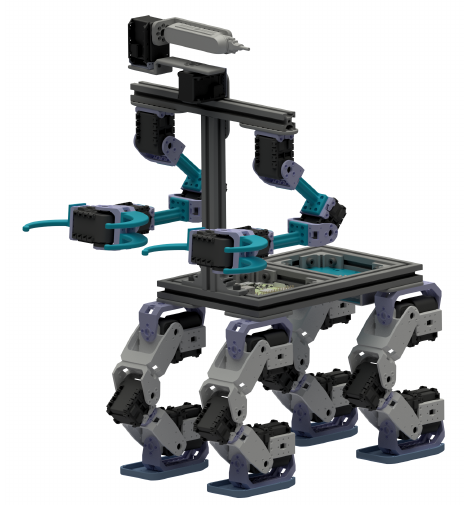
Figure 29. An alternative design with four legs like a centaur that a student designed for an environment with